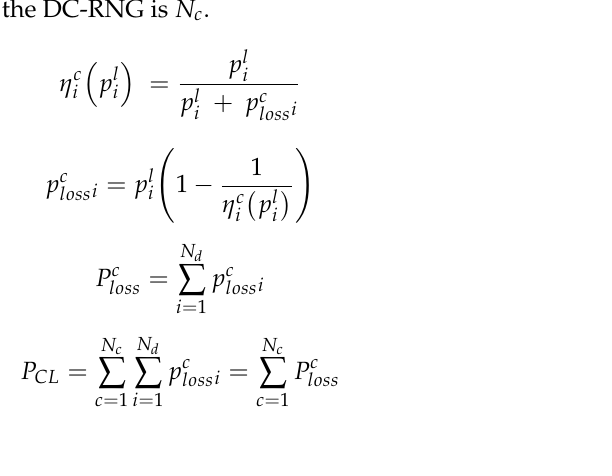
Figure 1. DC-RNG structure and components: ( a ) symbol guide, ( b ) structure.